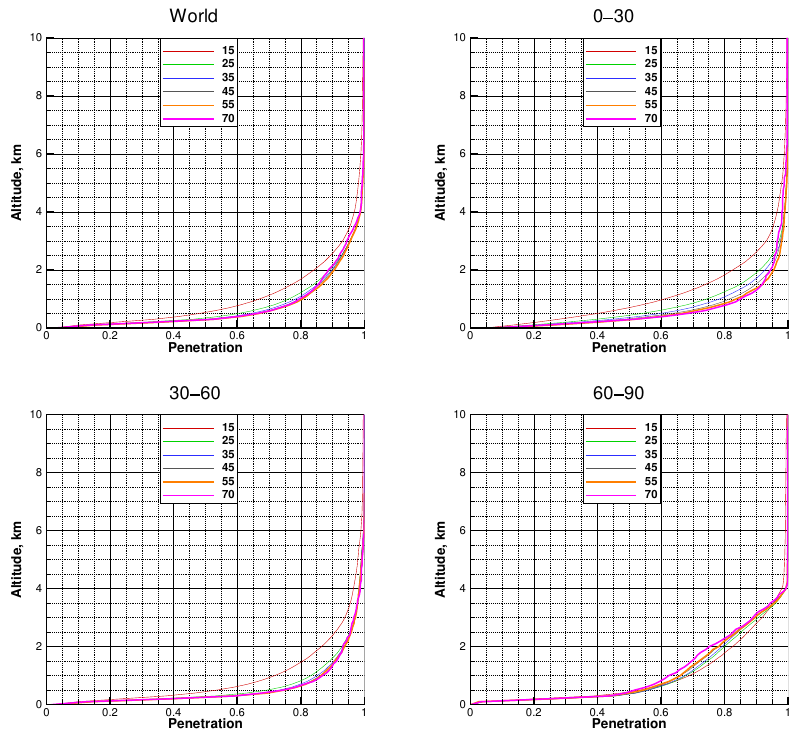
Figure 10. Similar to Figure 4. Spire,